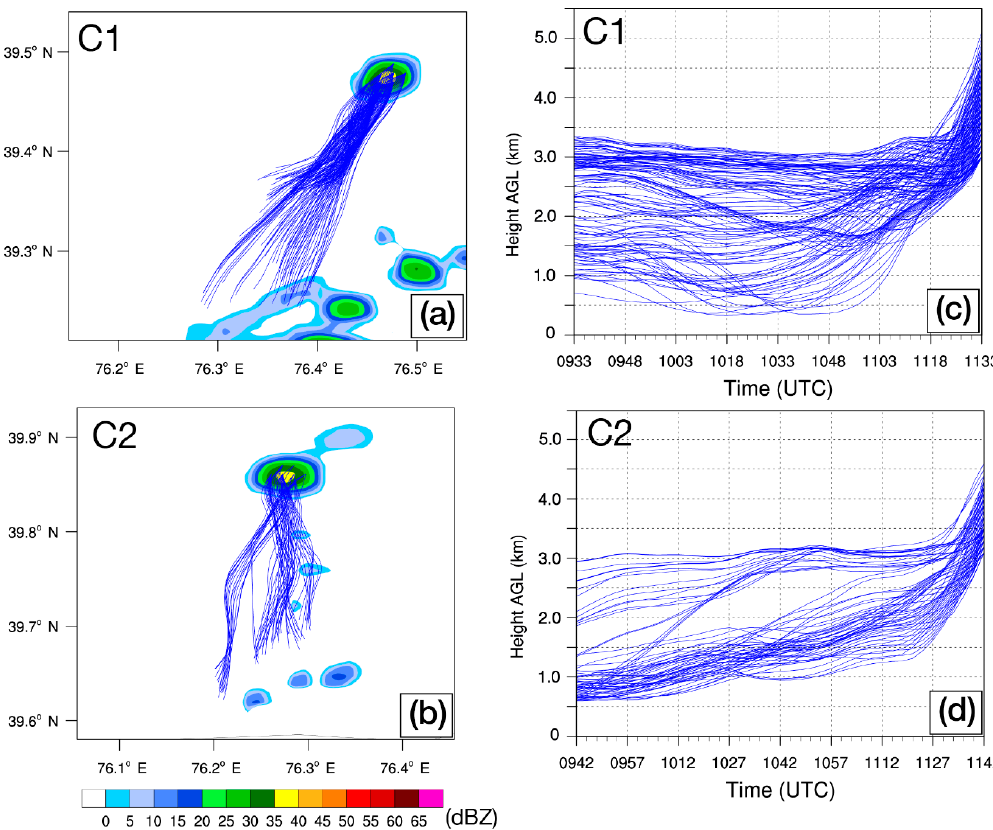
Figure 9. ( a , b ) Simulated composite reflectivity (shading; unit: dBZ) and ground-relative backward trajectories (blue lines, projected to the ground) of air parcels for 2 h within the two convective cells released at the CI time of 1133 and 1142 UTC, respectively, on 23 June 2015. ( c , d ) Height along the backward trajectories of air parcels within the two convective cells.